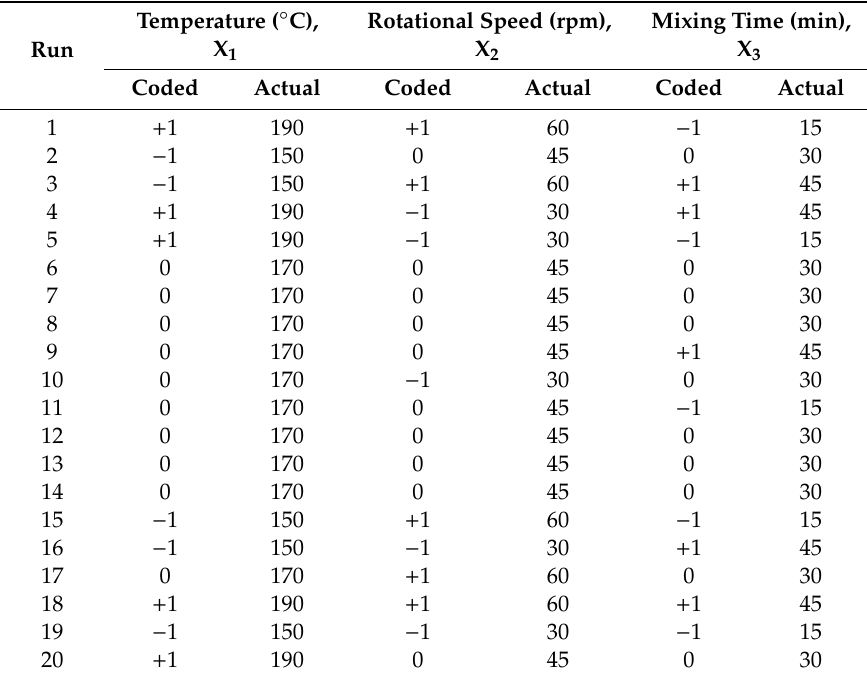
Table 6. Central composite design matrix of coded and actual factor